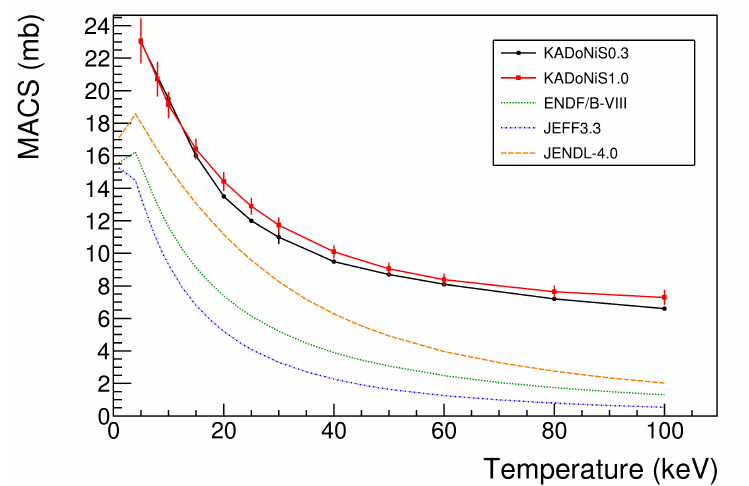
Figure 2. The MACS calculated with the resonance parameters provided by major libraries compared with the values reported in KADoNiS0.3 and